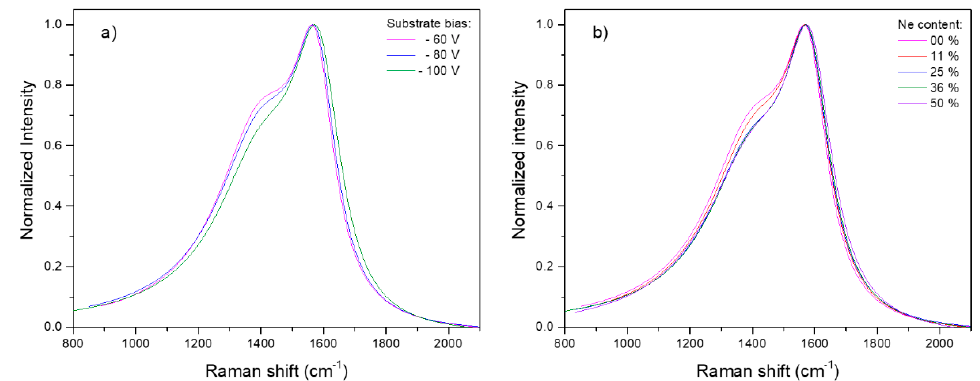
Figure 7. Raman spectra of the DLC films as a function of the substrate bias ( a ) and the Ne content in the plasma ( b ).